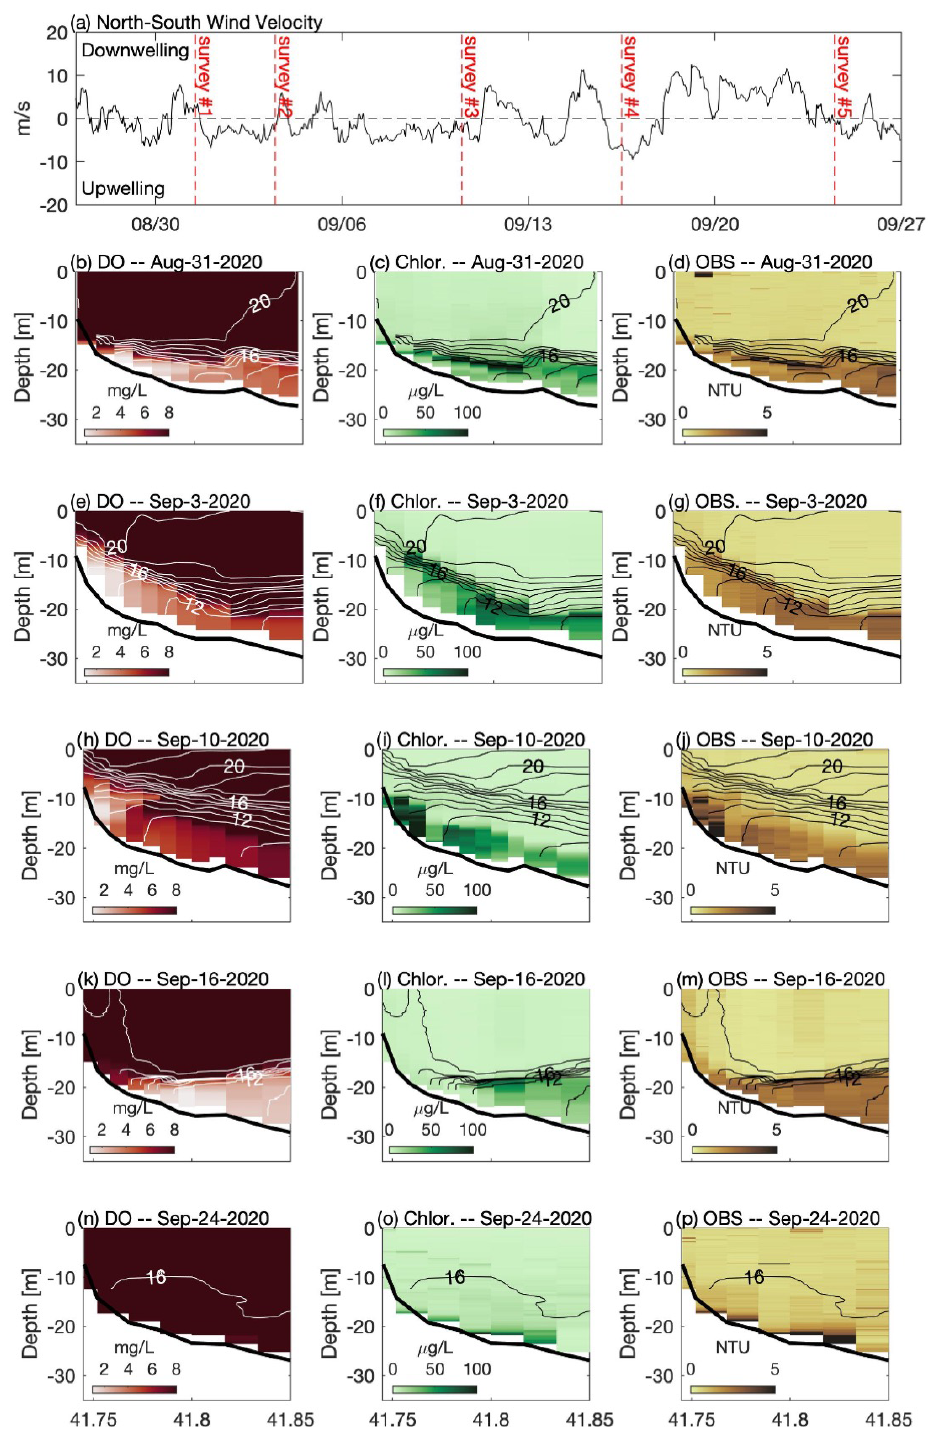
Figure 3. (a) North–south component of wind measured at NDBC buoy 44013. Panels on the left (b,e,h,k,n) show across-shelf transects of dissolved oxygen, panels in the center (c,f,i,l,o) show chlorophyll fluorescence, and panels on the right (d,g,j,m,p) show optical backscatter measured during a series of cruises in late summer 2020. For each transect, temperature contours (1 ◦ C interval) are shown. In the top panel the vertical dashed red lines indicate the approximate timing of each cruise. Note that 31 August and 16 September followed downwelling winds (positive), and 3 and 10 September were during a period of prolonged upwelling-favorable winds (negative). See Fig. 1 for location of transect and wind